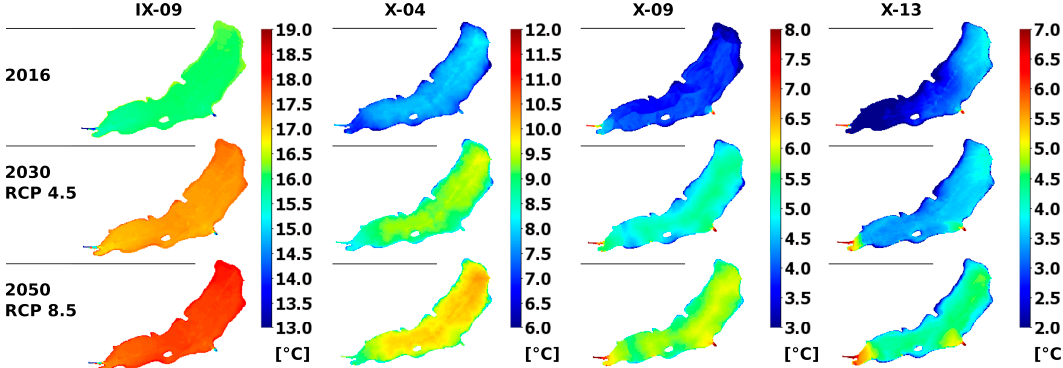
Figure 10. Maps of depth averaged water temperature in September and October 2016 and in two climate change